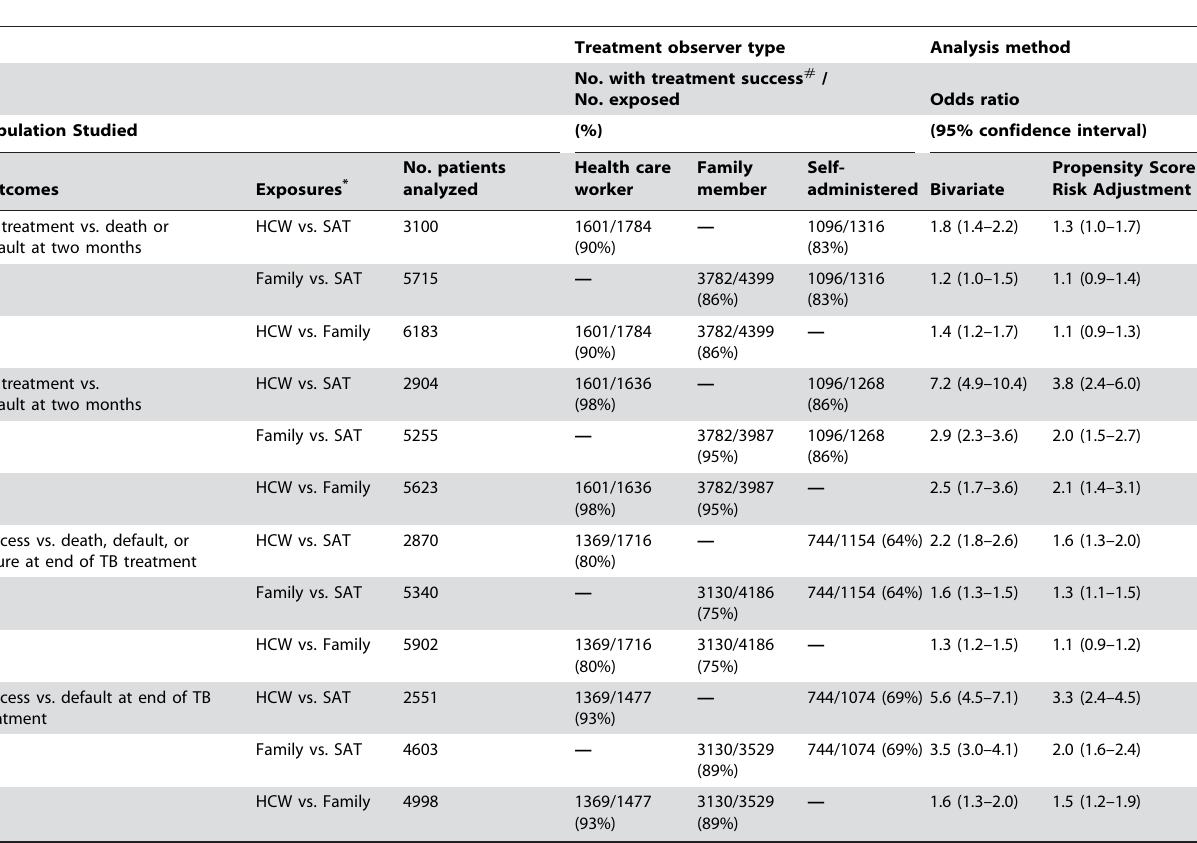
Table 3. Bivariate and multivariate measures of association for successful TB treatment and health care worker observed, family member observed, and self-administered